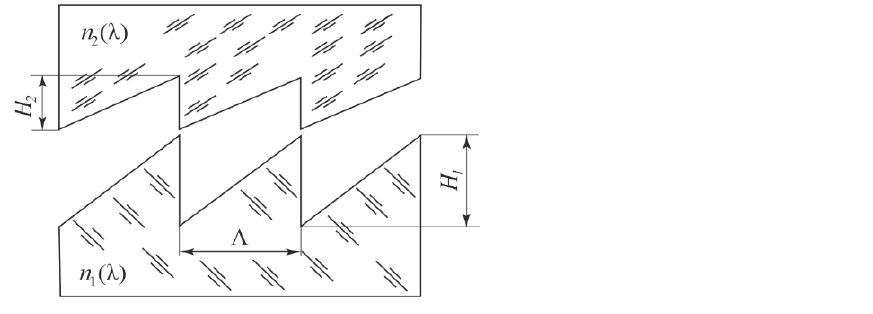
Figure 2. Two-layer and double-relief microstructure made of optical materials with refractive indices n 1 ( λ ) and n 2 ( λ